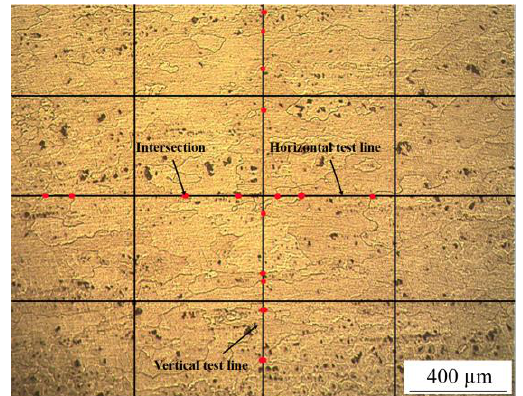
Figure 1. Sketch of the line intercept method.